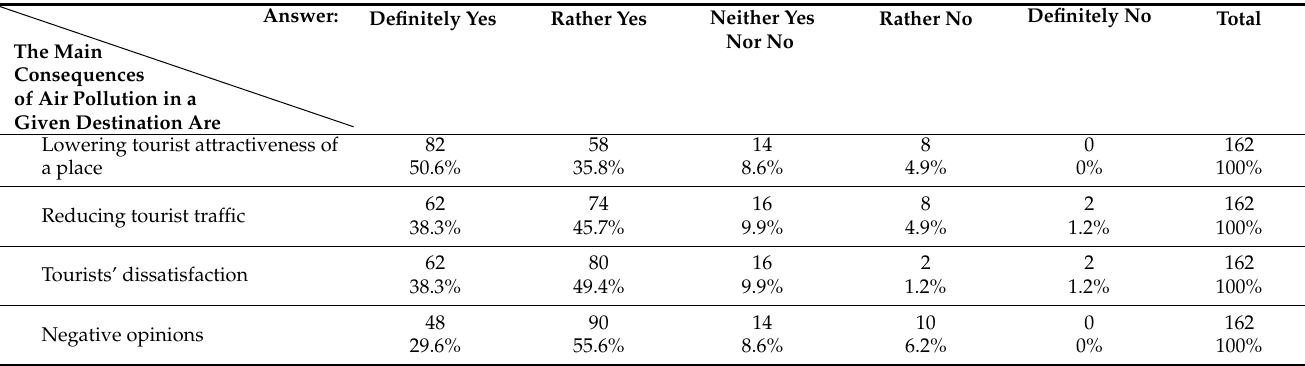
Table 4. Perceived consequences of air pollution in the respondents’